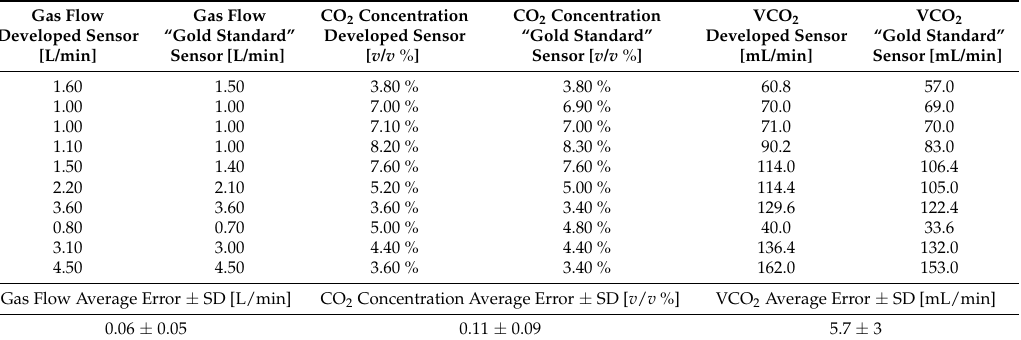
Table 2. Error between measurement taken with the newly developed system and the “gold standard” devices for CO 2 concentration, Gas Flow, and VCO 2 . Error is expressed as average value and standard deviation